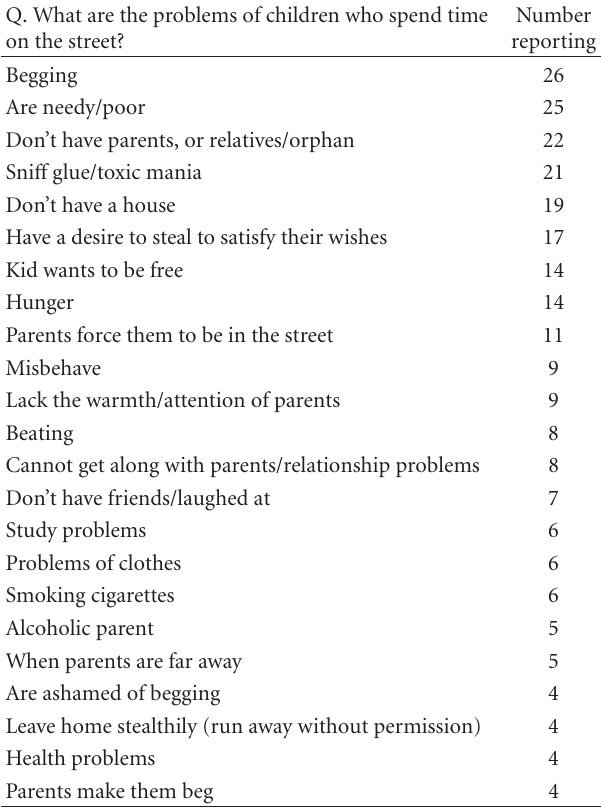
Table 6: Study 2 free list responses, problems of children on the street, all centers ( N =